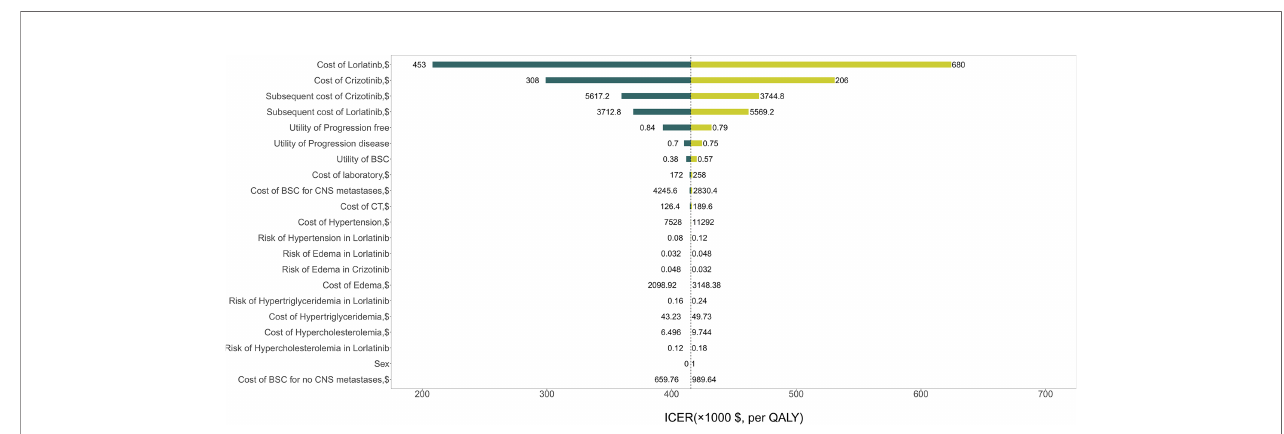
FIGURE 2 | Tornado diagram for univariable sensitivity analysis. *ICER, Incremental cost-effectiveness ratio; BSC, Best supportive care; CNS, Central nervous system; AEs, Adverse events.